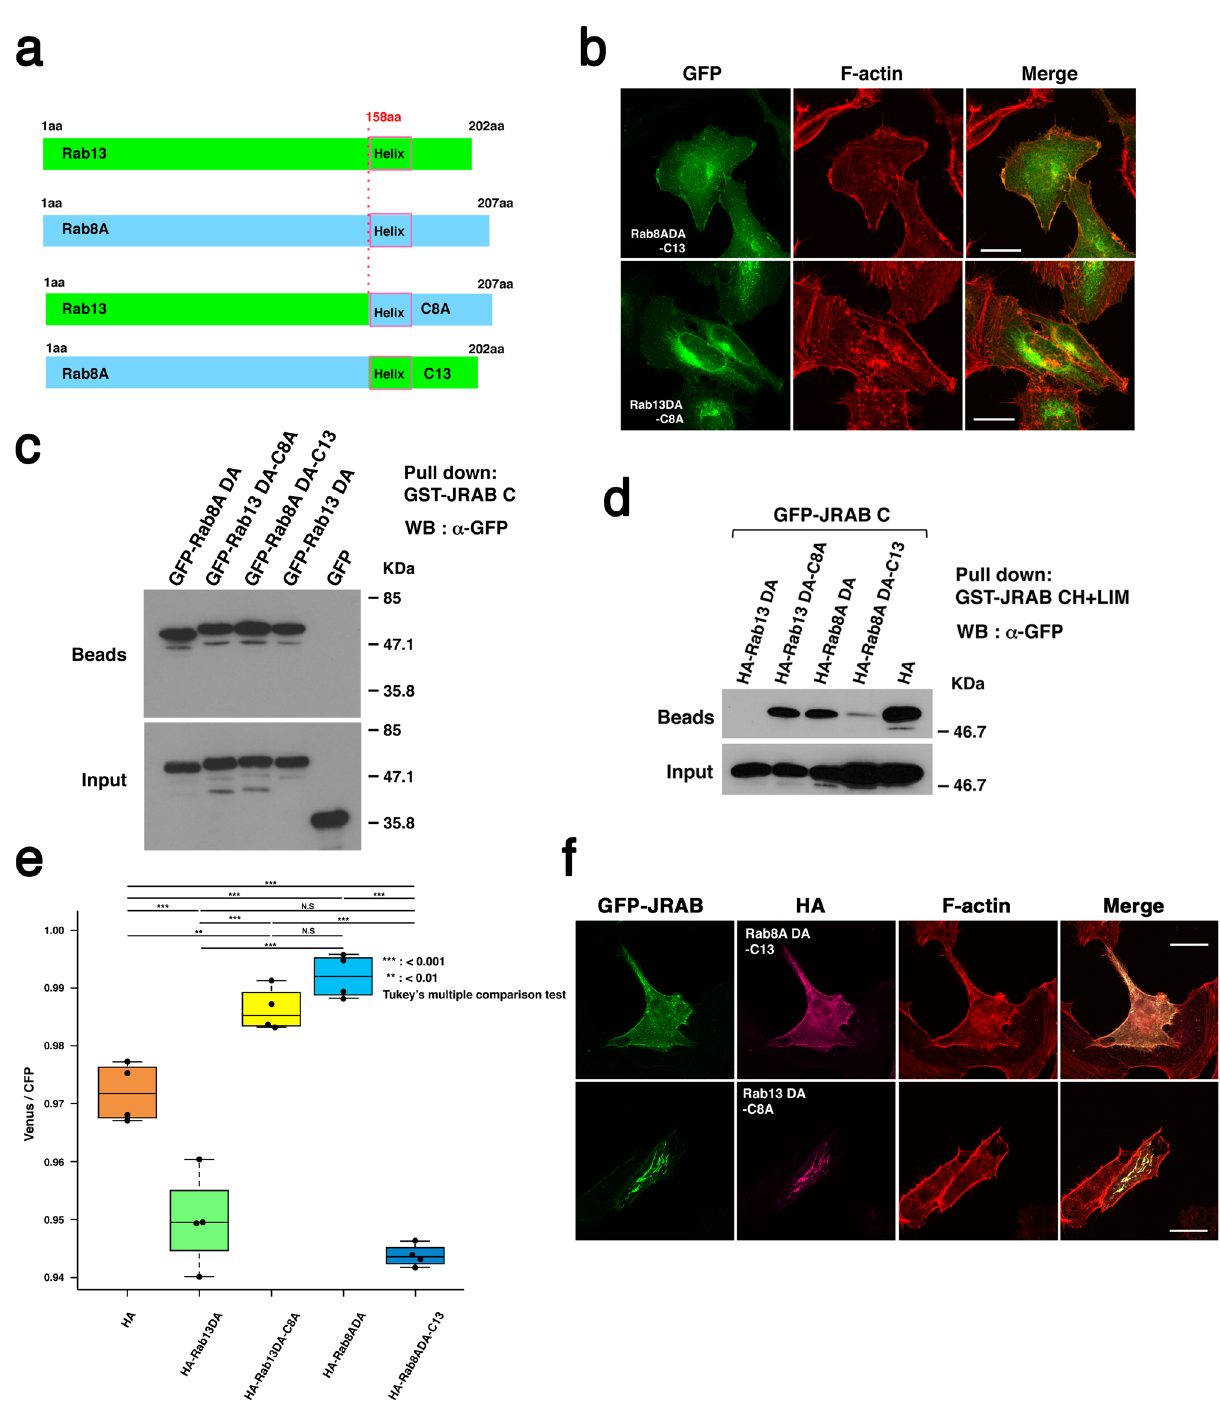
Fig. 3 Association of the closed form JRAB/MICAL-L2 with Rab8A and C terminus of Rab8A Is necessary for endosomal tubulation. a HeLa cells expressing HA-Rab8ADA with GFP-JRAB Δ LIM ( Δ LIM) or GFP-JRAB (wt) were fi xed and stained with anti-HA antibody, followed by rhodamine – phalloidin staining. Scale bar, 25 μ m (upper), 10 μ m (lower). The schematic shows that JRAB Δ LIM associates with GTP-Rab8A (active form) in the open form. b HeLa cells transfected with GFP-JRAB Δ CT and HA-Rab8ADA were fi xed and stained with anti-HA antibody, followed by rhodamine – phalloidin staining. Scale bars, 25 μ m. c HeLa cells transfected with GFP-Rab8ADA Δ C3 (upper panels) or GFP-Rab8ADA (lower panels) were fi xed and stained with rhodamine – phalloidin. Scale bars, 25 μ m. The schematic summarizes the sequence structure of the Rab8A truncated mutant. Cys204 represents the position of amino acid with a geranylgeranyl modi fi cation. d HeLa cells co-transfected with GFP-JRAB and HA-Rab8ADA Δ C3 (upper panels) or HA- Rab8ADA (lower panels) were fi xed and stained with anti-HA antibody, followed by rhodamine – phalloidin staining. Scale bar, 25 μ m. More than 40 transfected cells from four individual preparations were examined, and representative images are shown ( a – d